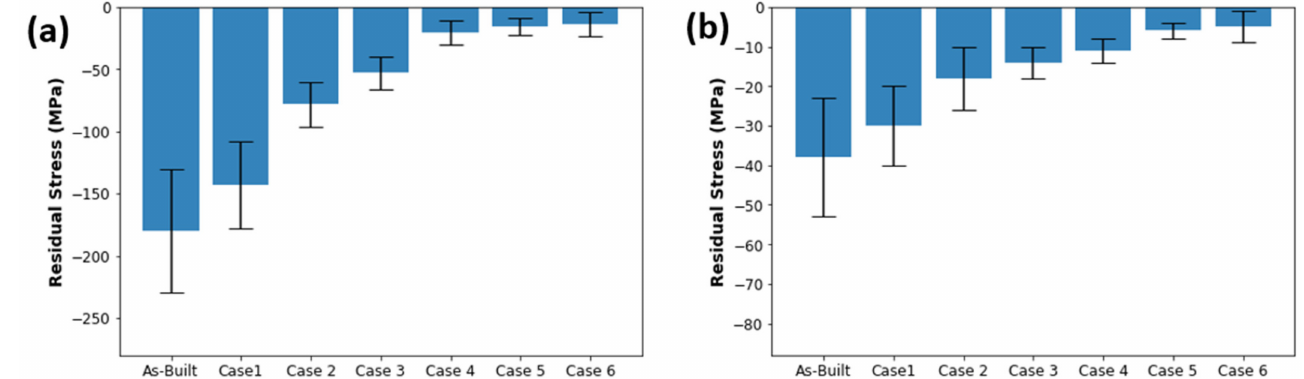
Figure 6. Residual stress on the: ( a ) transverse plane, ( b ) sagittal